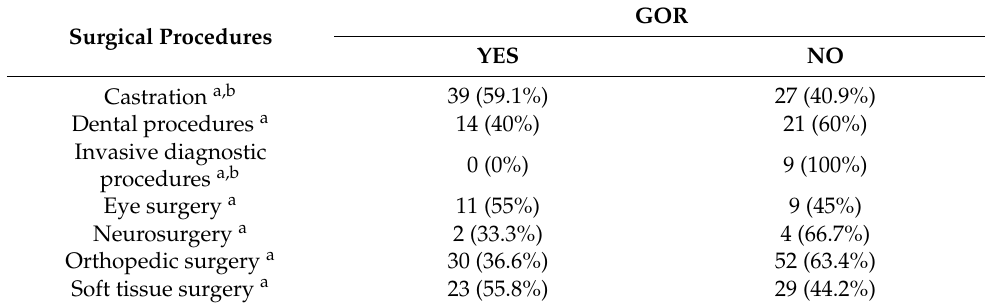
Table 6. The incidence of GOR within the surgical procedures in dogs submitted to esophageal pH-measurement during anesthesia for non-intrabdominal, non-intrathoracic